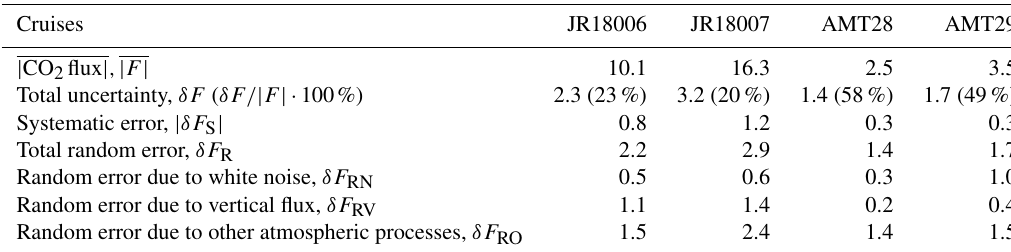
Table 4. Summary of hourly average EC CO 2 fluxes and associated uncertainties in the mean for the four cruises (mmolm − 2 d − 1 ). Shown are the mean CO 2 flux magnitude ( | F | , mmolm − 2 d − 1 ), upper limitation of the total uncertainty ( δF ; Eq. 3), upper limitation of the absolute systematic error ( | δF S | ; propagated from Table 2 and Eq. 5), and random error ( δF R ; Eq. 6). The random error components are white noise ( δF RN ; Eq. 10), vertical flux ( δF RV ; Eqs. 7 and 8), and other atmospheric processes ( δF RO = is also expressed as a percentage of the mean flux magnitude ( δF/ | F |·